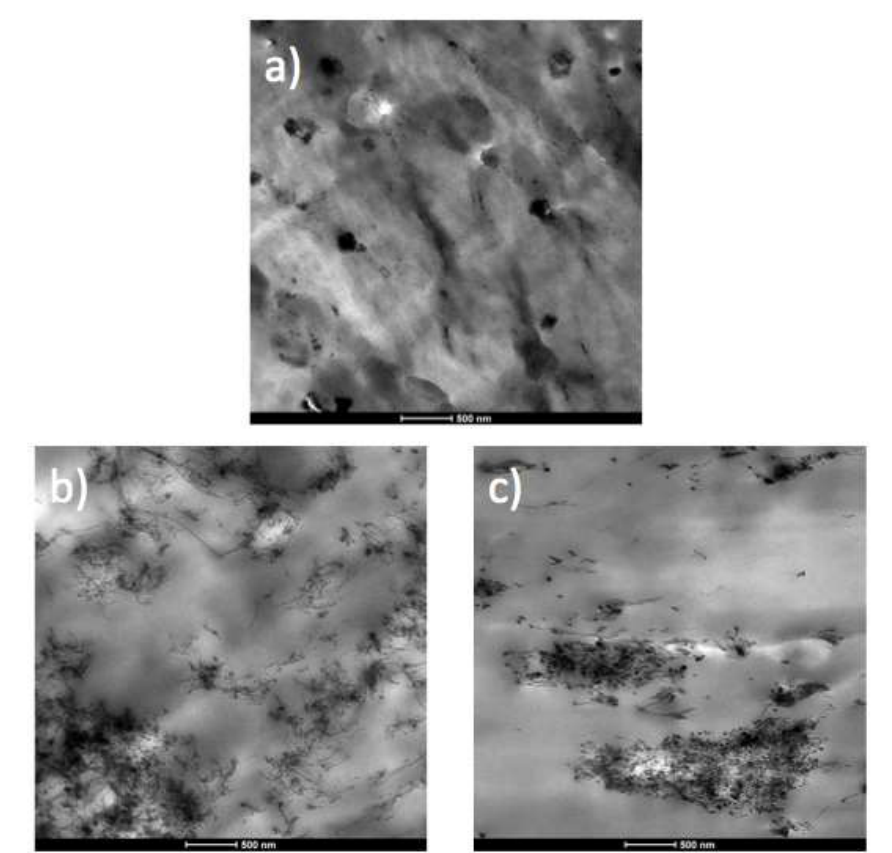
Figure 1. TEM images of the recycled poly(propylene) (PP) and the different polymer/carbon nanotubes (CNT) nanocomposites. ( a ) Rec-PP, ( b ) PP/CNT and ( c ) Rec-PP/CNT.